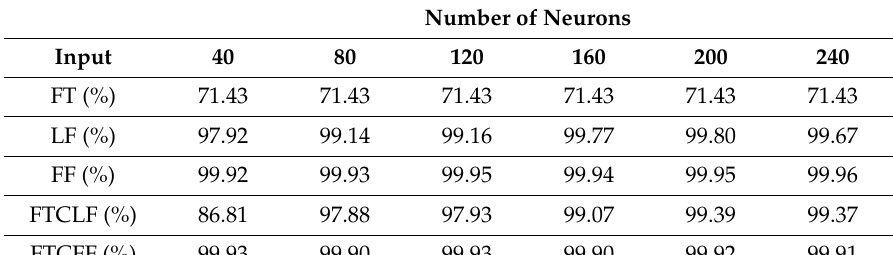
Table 5. Accuracy results of the test set (content: accuracy).